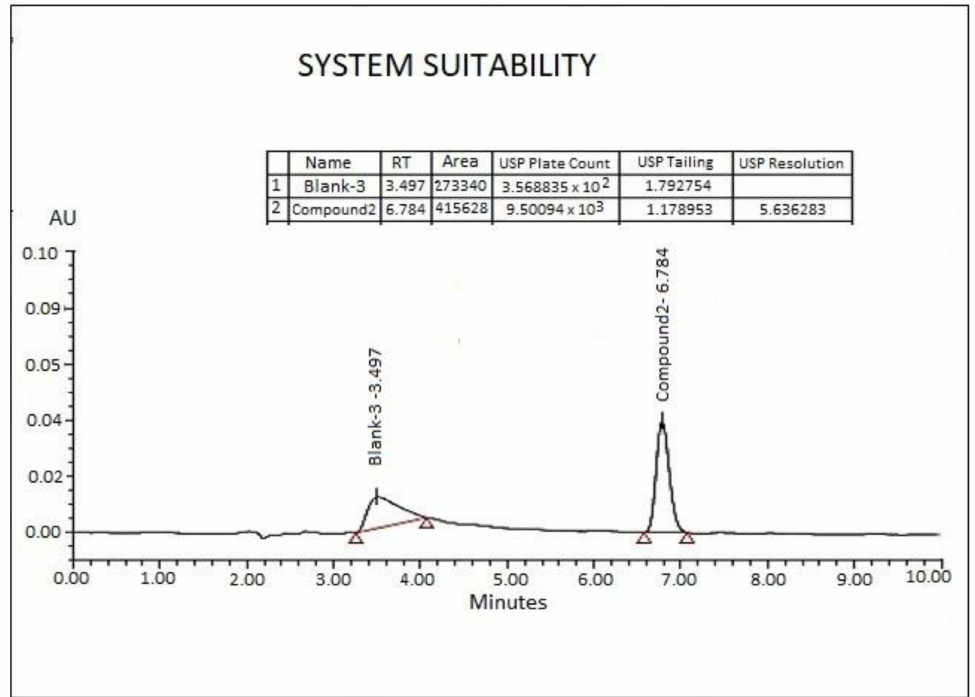
Figure 5. The UPLC chromatogram showing the systems suitability performance of the sam- ple run. Note: * The chromatographic conditions: A Waters Acquity ® , UPLC C18 BEH column (2.1 × 50 mm, 1.7 µ m) kept at 35 ◦ C. The detector wavelength was set at 234 nm for compound ( 2 ) and isatin,